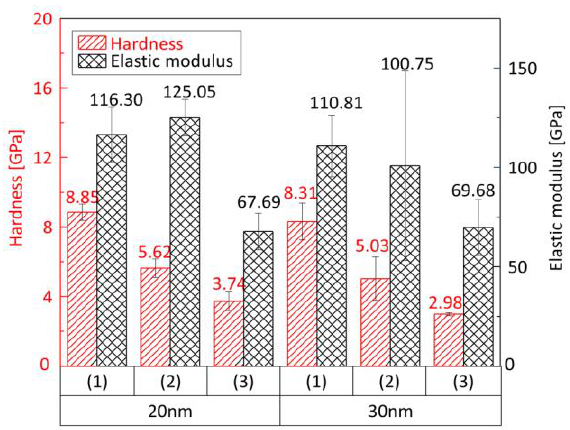
Figure 8. Results of the nano-indentation hardness test before and after anodizing under different conditions (1) as-received surface; (2) 30 V 600 s; (3) 50 V 1200 s.